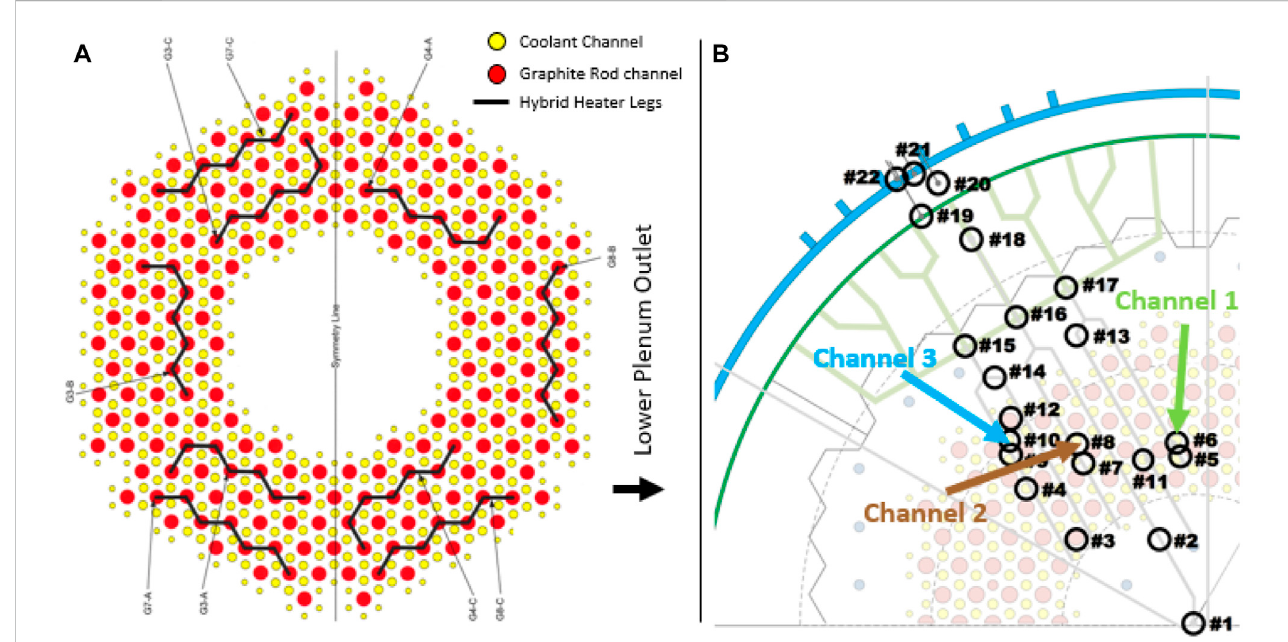
FIGURE 6 (A) PG-27 hybrid heater con fi guration; (B) Selected instrumented coolant channels for PG-27 experimental data